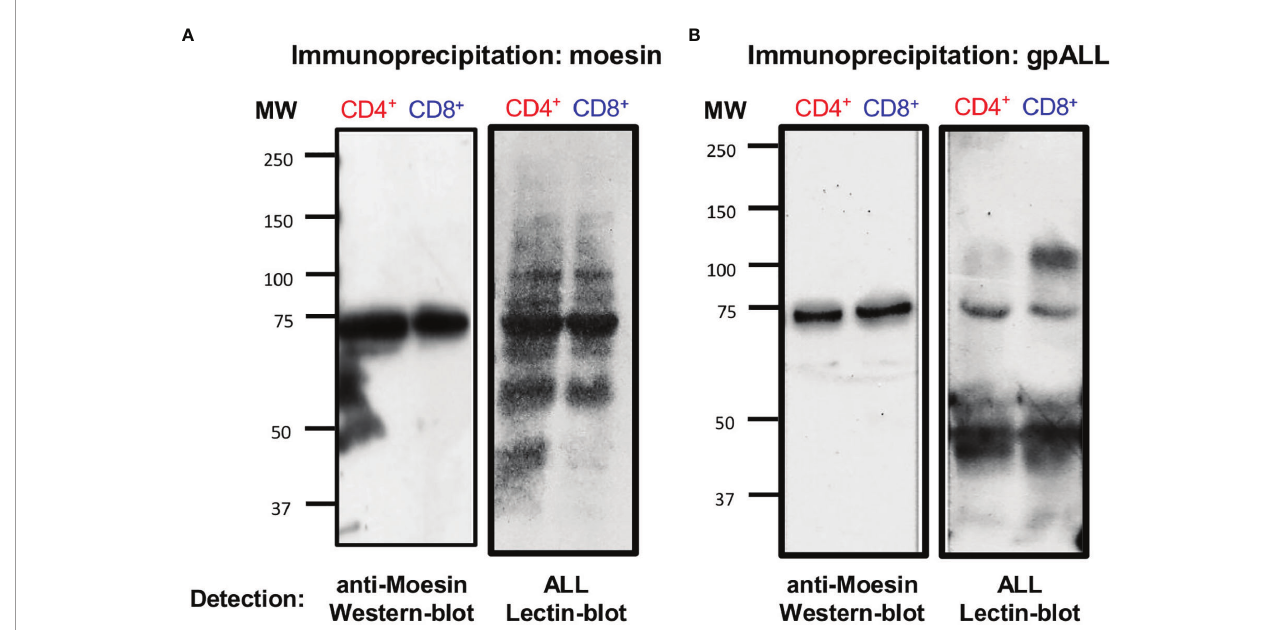
FIGURE 4 | Moesin is the 70-kDa O -glycoprotein recognized by ALL in CD4 + and CD8 + lymphocytes. T cell protein extracts from 48 h stimulated cells were obtained as described in Figure 2 and precipitated with (A) anti-moesin mAb or (B) ALL using the µMACS separation system. Proteins were separated by SDS- PAGE, then, western and lectin blots were developed with anti-moesin ( A and B , left) and ALL ( A and B , right), respectively. The experiment was performed twice with comparable